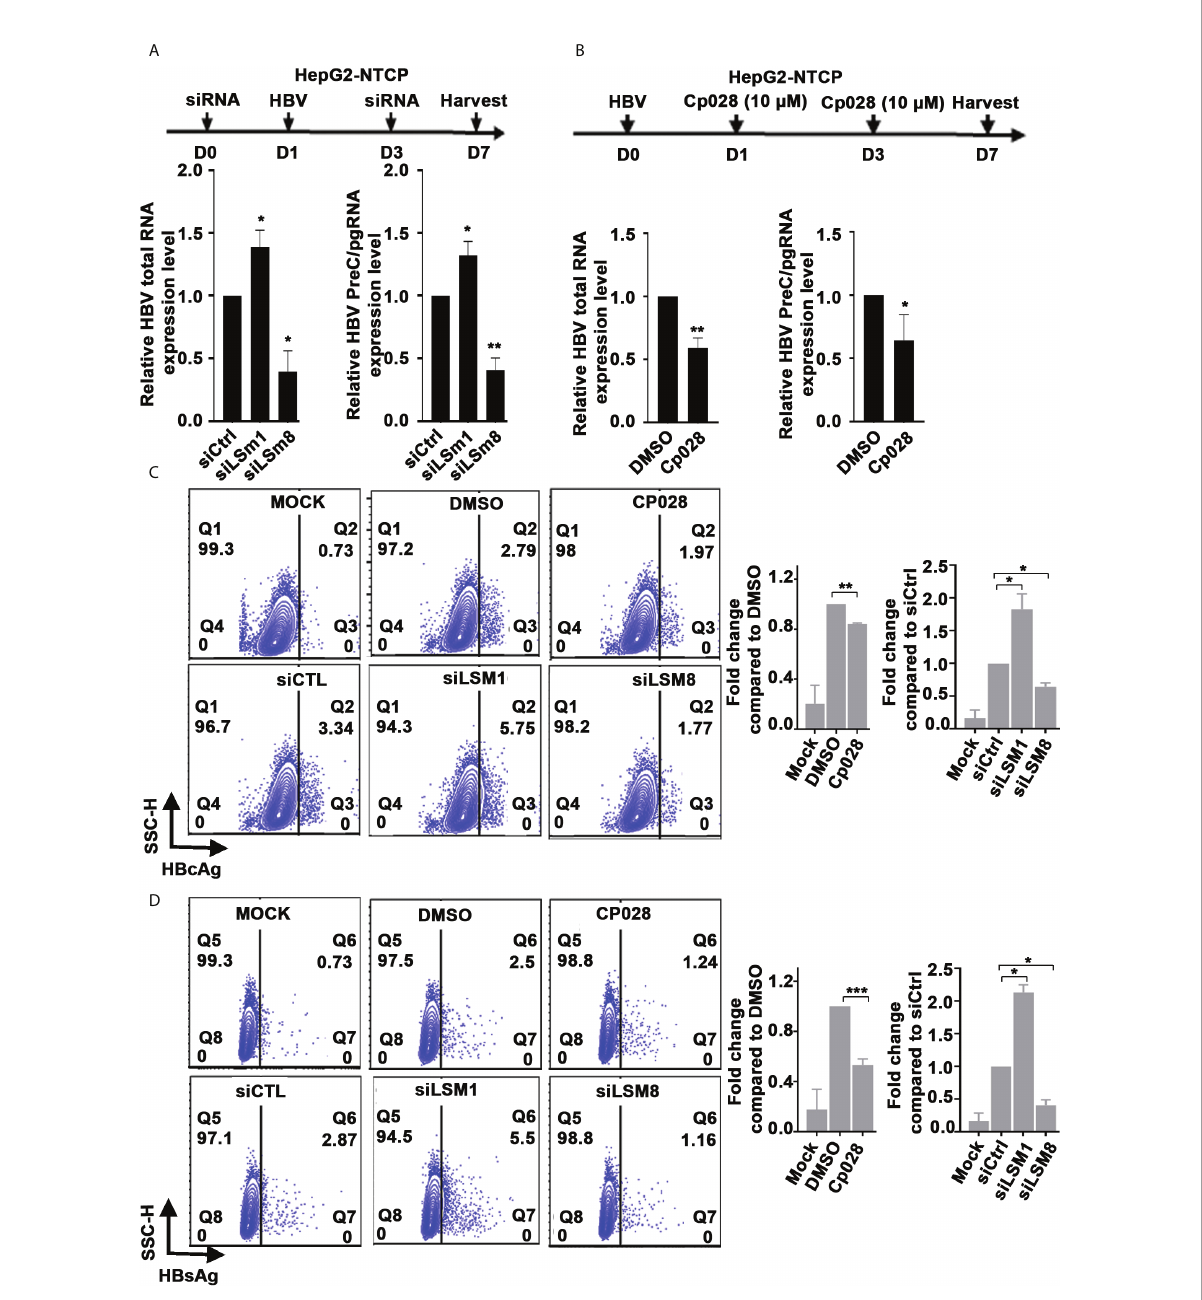
FIGURE 4 Role of LSm complexes in HBV biosynthesis using an HBV infection model. (A) Diagram shows treatment timeline of HepG2-NTCP cells. On day 0, cells were transfected with 50pM of indicated siRNAs (siCtrl, siLSm1, or siLSm8), infected with 100vge/cell of HBV on day1, followed by another siRNA transfection on day 3. Cells harvested on day7 for preparation of RNA and qRT-PCR analyses of total HBV RNA and preC/pg RNA. n=3, *p<0.05, ** p<0.01 (B) Timeline of HepG2-NTCP infection with HBV (100vge/cell) and treatment with Cp028 (10µM). Cells harvested on day7 for preparation of RNA and qRT-PCR analyses of total HBV RNA and preC/pg RNA. n=3, *p<0.05, ** p<0.01 (C, D). Flow cytometric quanti fi cation of HBV infected HepG2-NTCP cells (500vge/cell), on day7 post-infection under conditions described in (A) , using anti-HBc (C) or anti-HBsAg (D) Mock, indicates uninfected cells; DMSO added to HBV infected cells as vehicle control for Cp028 addition to HBV infected cells. A representative image shown. Right panels are quanti fi cation of HBc-positive and HBsAg-positive cells from three independent experiments. *p<0.05, **p<0.01,